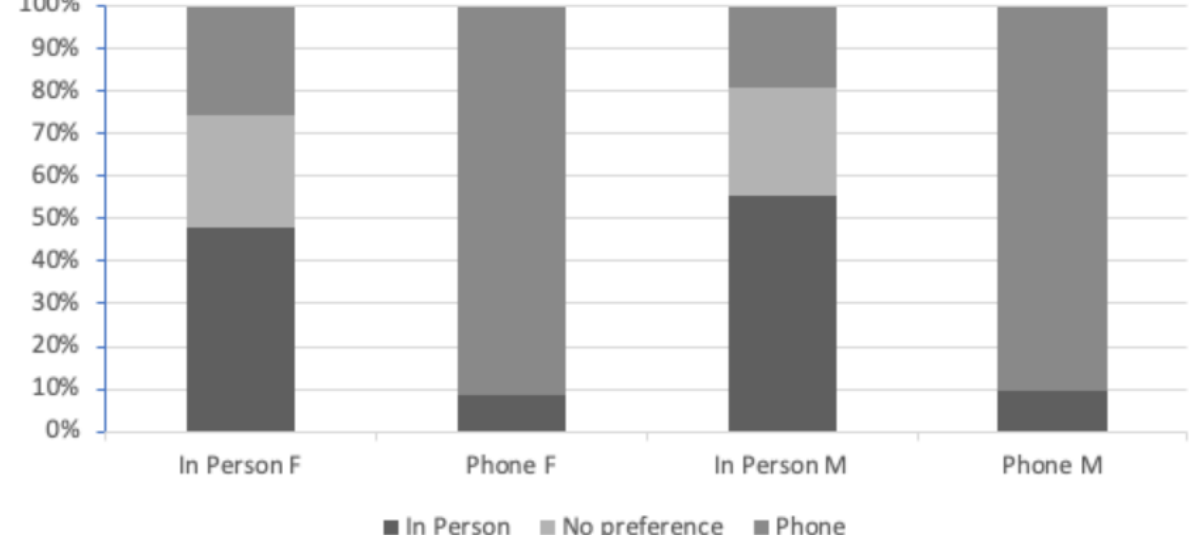
(Table S2 in Multimedia Appendix 1; P <.001). A striking 97.4% (191/196) of city dwellers in the telephone group preferred teleconsultation over in-person office visits compared to 81.3% (130/160) of patients living in a rural